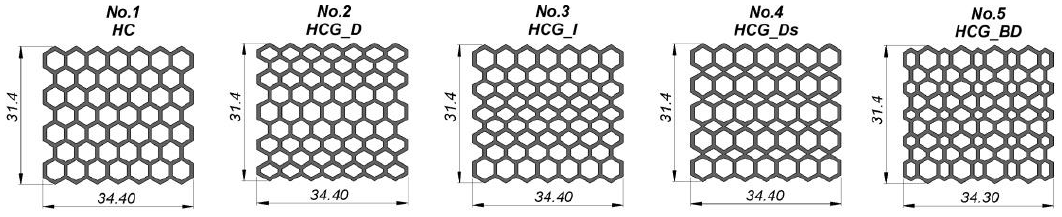
Figure 2. The main view of developed structure specimens with different topologies.